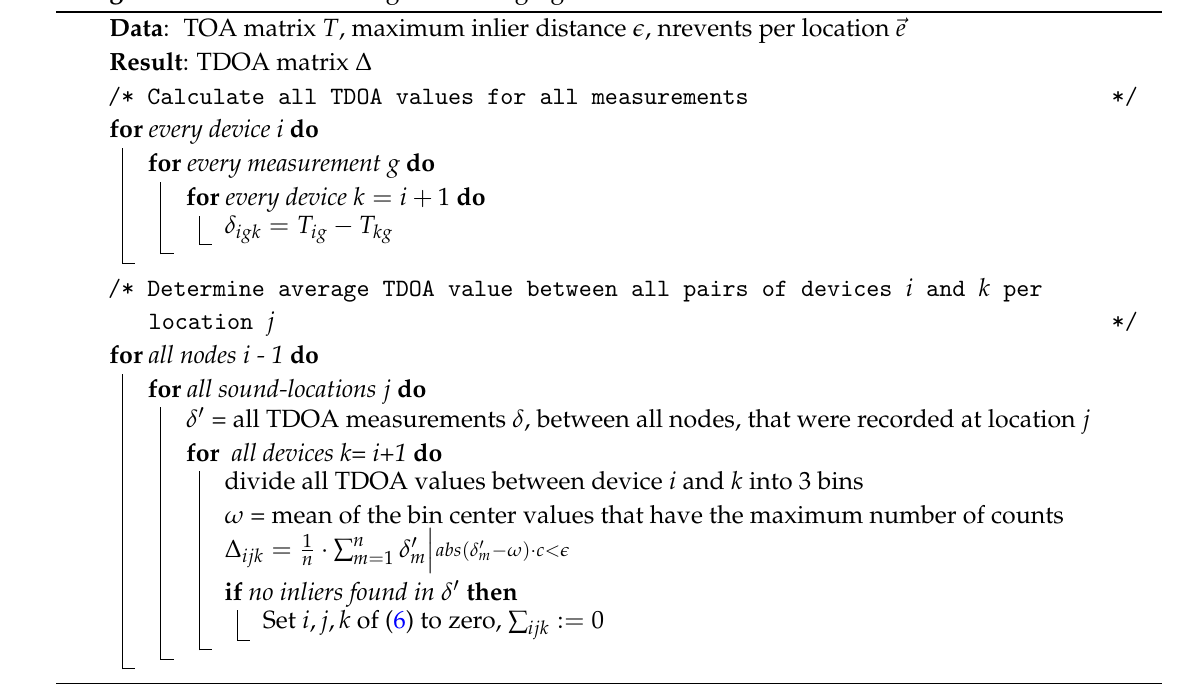
Algorithm 1: TDOA filtering and